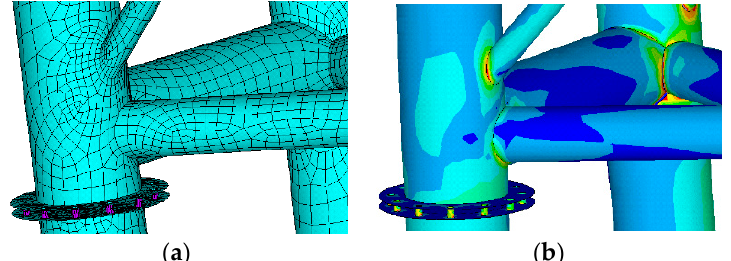
Figure 1. ( a ) Finite element (FE) numerical mesh for a gantry boom and ( b ) its typical stress contour results.